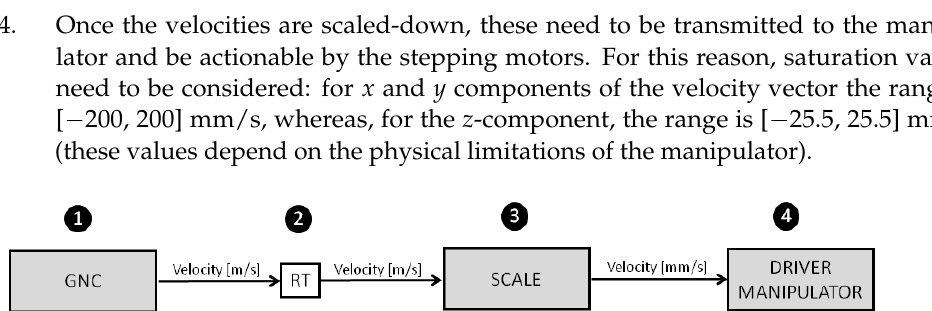
Figure 19. High level blocks of the implemented model.